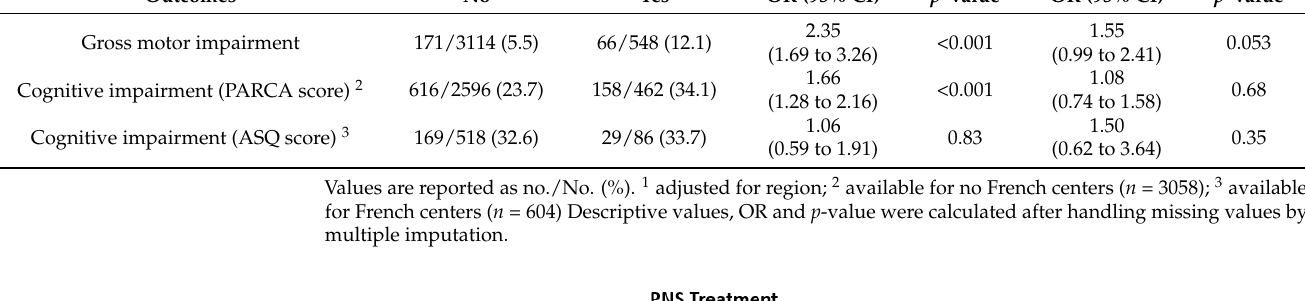
Table 2. Comparison of two-year neurodevelopmental outcomes in PNS and non-PNS treated infants. PNS Center Adjusted Model IPTW Model 1